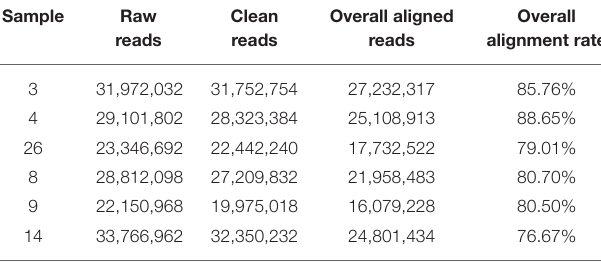
TABLE 2 | Summary of reads generated by RNA-seq for each sample.